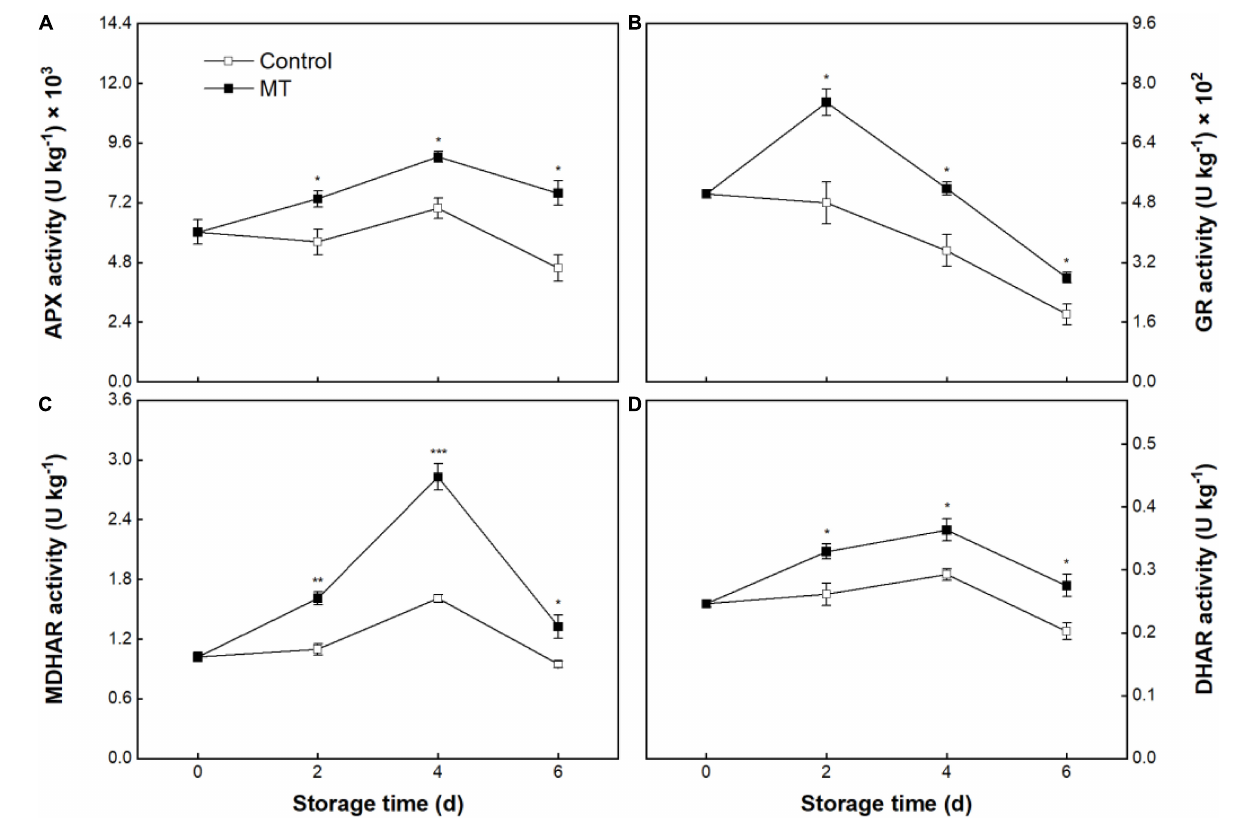
FIGURE 8 | Activities of ascorbate peroxidase (APX) (A) , glutathione reductase (GR) (B) , monodehydroascorbate (MDHAR) (C) , and DHAR (D) in “Baoyan 7” rambutan fruit during storage at 25 ◦ C after treatment with 0.125 mmol L − 1 MT or water (control). The vertical lines represent the SE of triplicates while the asterisks indicate a significant difference between the MT group and the control group on the same day (* p < 0.05, ** p < 0.01, and *** p <